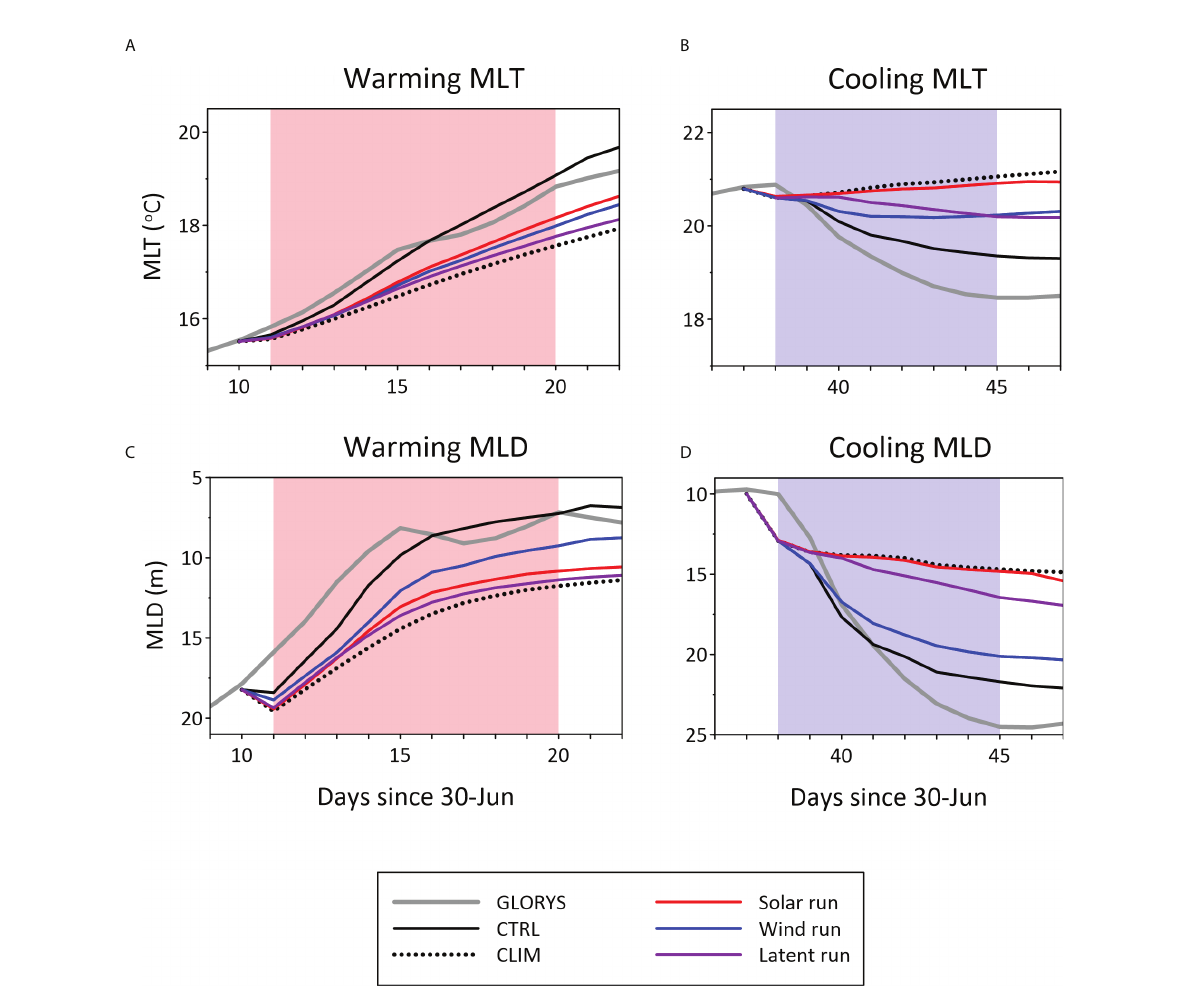
FIGURE 11 Time series plots of (A, B) mixed-layer temperature (MLT) and (C, D) mixed-layer depth (MLD) from CTRL (black solid), CLIM (black dotted), SOLAR (red), WIND (blue), and LATENT (purple) overlaying those from ocean analysis data (GLORYS; gray) during the (A, C) warming period and (B, D) cooling